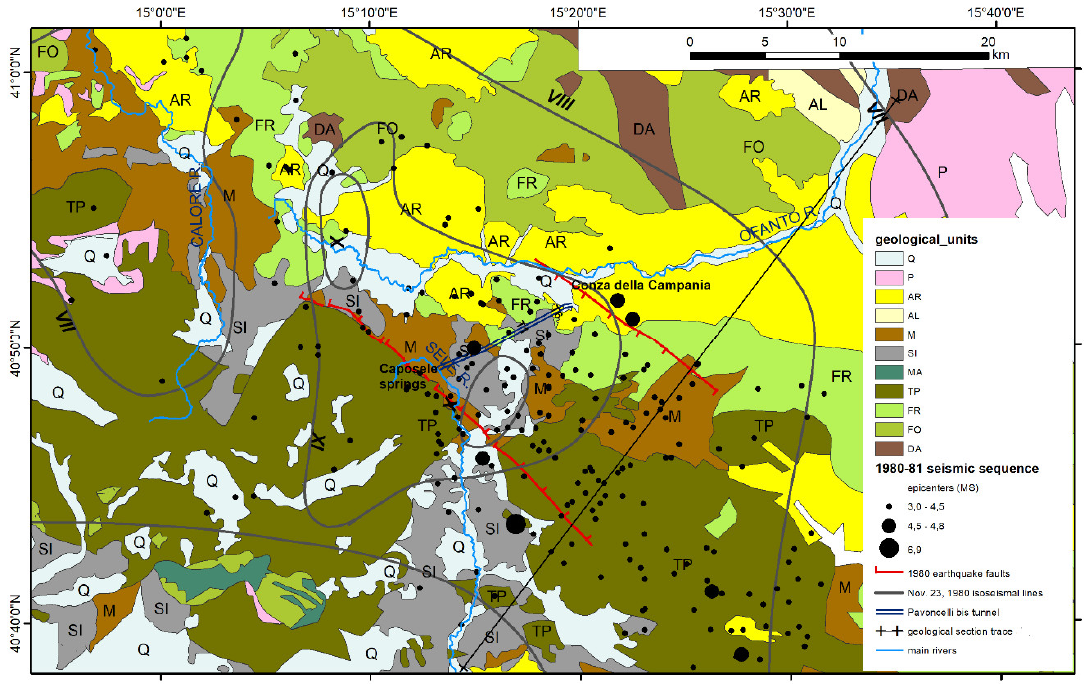
Figure 2. Geological map of the study area [17,18,20,21] and seismic effects of 1980 earthquake. Legend: Q , Quaternary deposits; P , pyroclastic and volcanic deposits; AR , Ariano unit (Pliocene); AL , Altavilla unit (Late Miocene); M , flysch units (Middle-Late Miocene); SI , Sicilide and Liguride units; MA , Monte Croce unit; TP , Apennine carbonate platform units; FR , Frigento unit (Lagonegro basin); FO , Fortore unit (Lagonegro basin); DA , Daunia unit. Isoseismal lines by Postpischl et al. [24]; earthquake faults by [6,7,12,14].